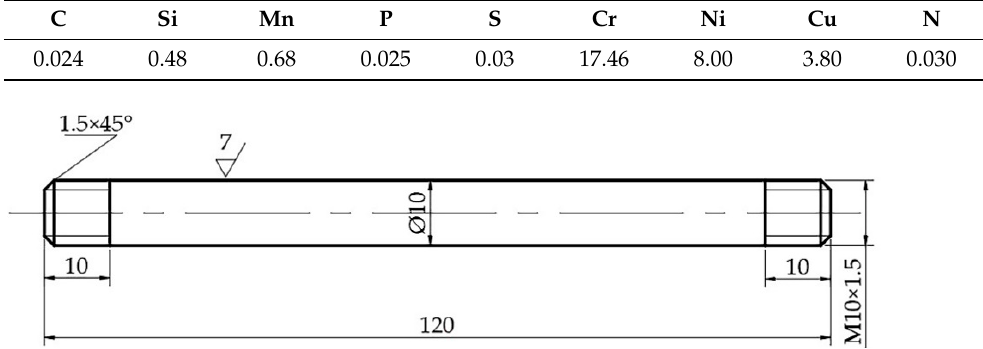
Table 1. Chemical compositions of 304-Cu antibacterial stainless steel (wt.%).